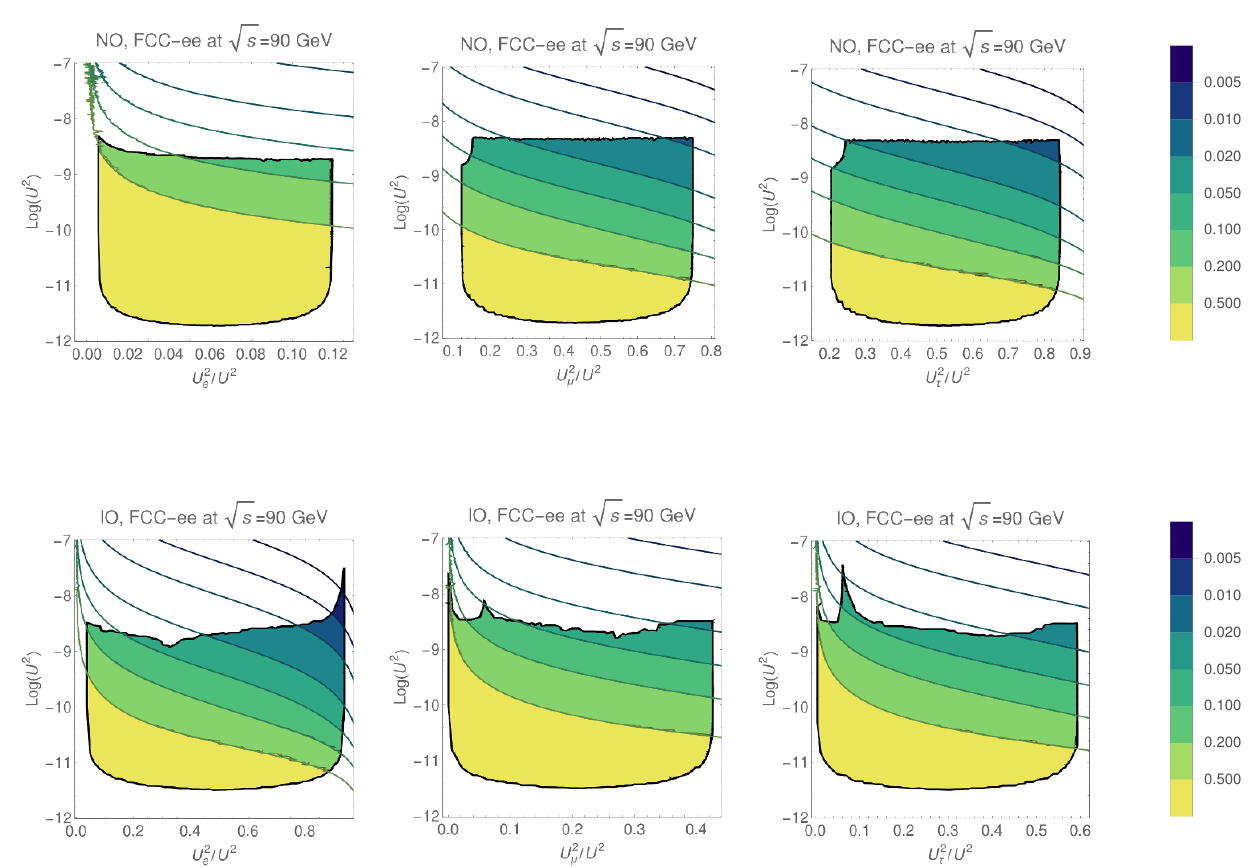
p =U 2 with a = e; (cid:22); (cid:28) at the FCC-ee with s = 90 GeV for a